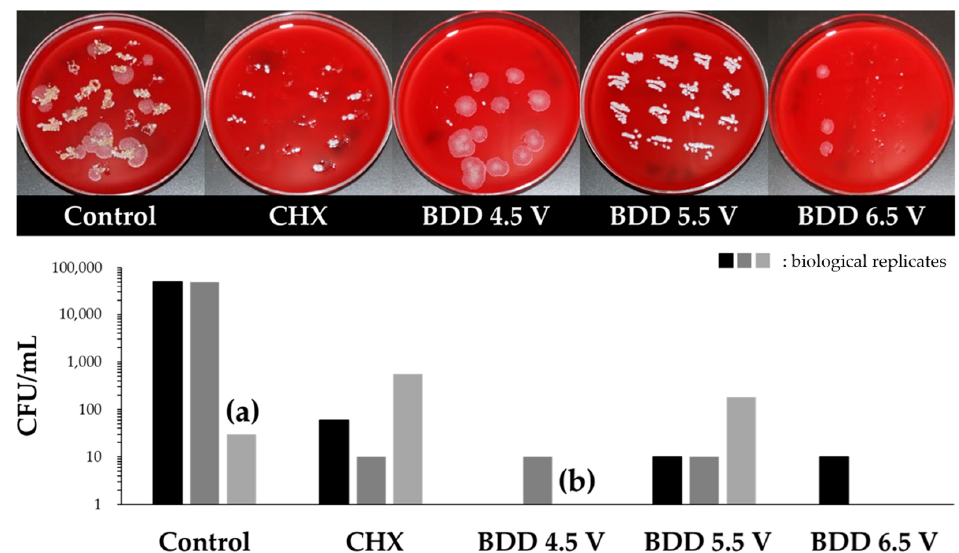
Figure 5. Elimination of multispecies biofilm. Upper panel : Bacterial growth on Columbia blood agar plates (typical examples are shown). Lower panel : Bacterial sampling using paper points and incubation in BHI. ( a ) technical problems during sampling, ( b ) condition only in duplicate.